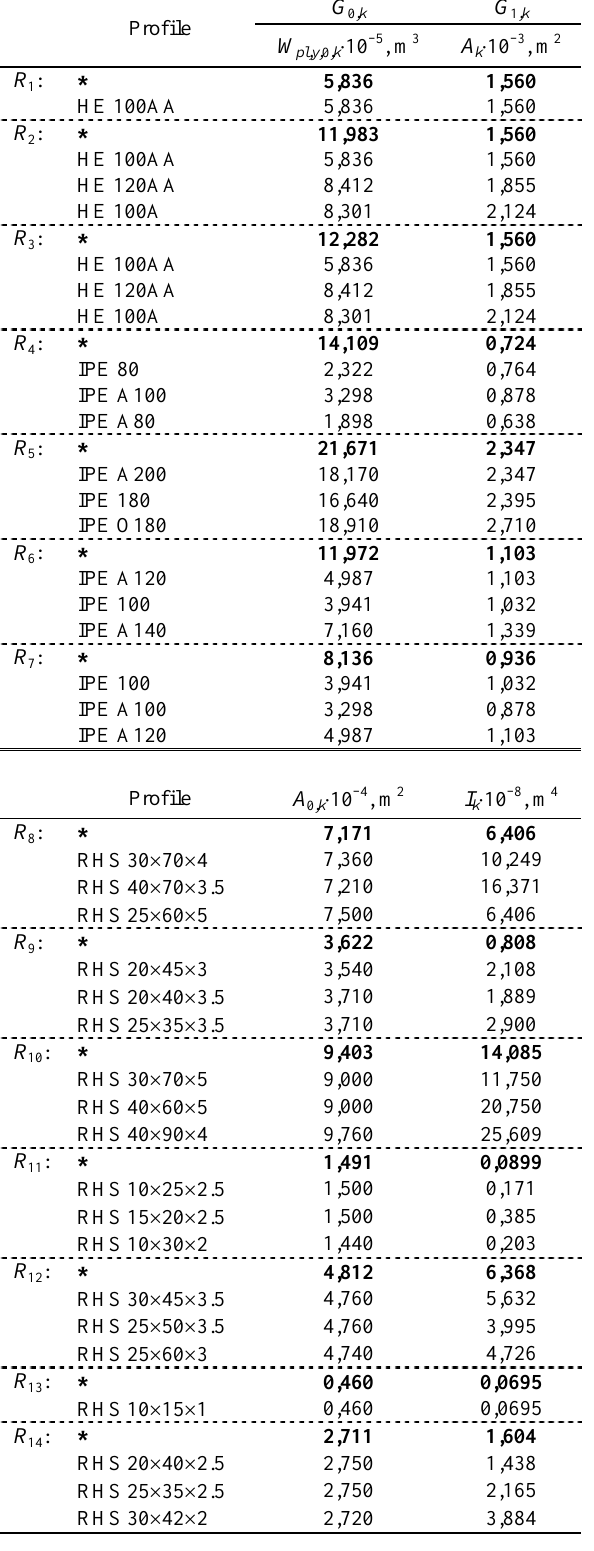
Table 3. Calculated optimal theoretical cross-sections (*) an the profiles closest to these cross-sections G 0